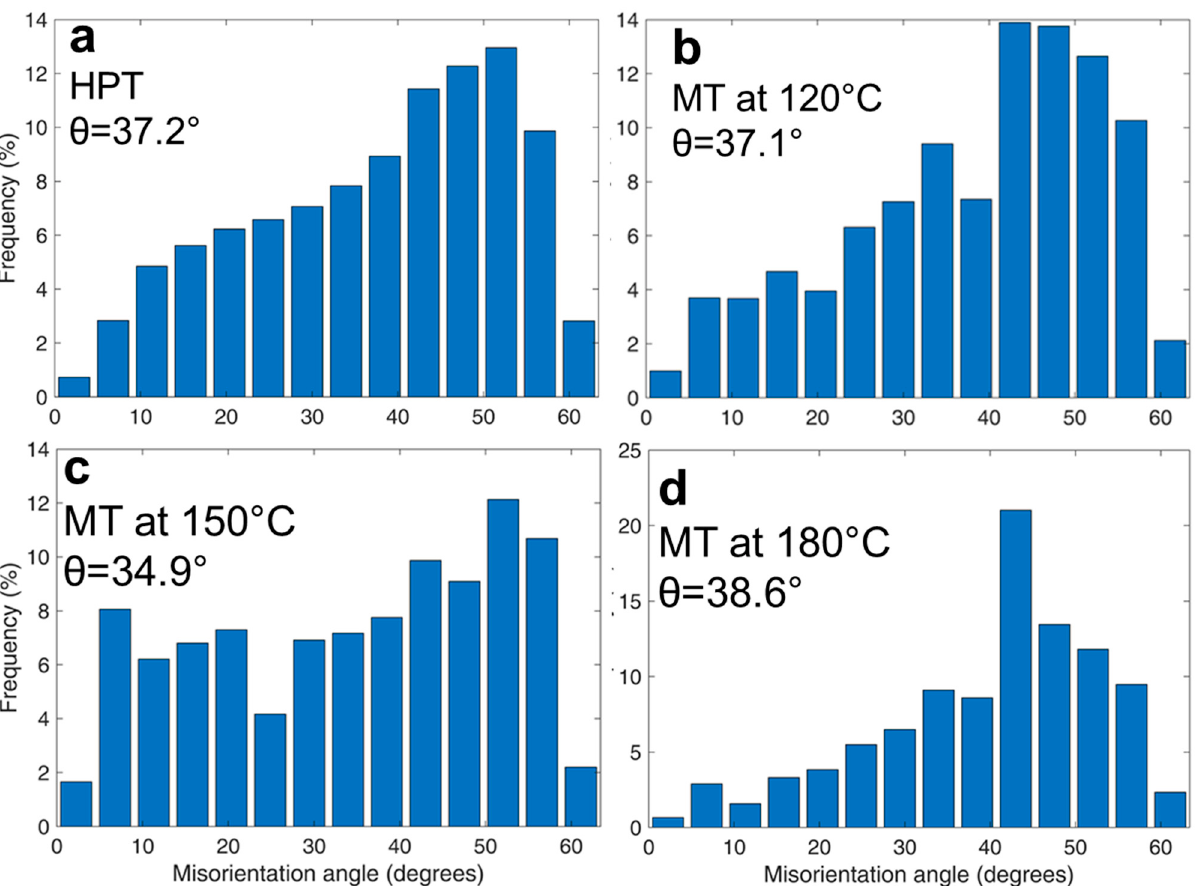
Figure 5. Distribution diagram of boundary misorientation angles depending on their volume fraction of UFG 6060 alloy after ( a ) HPT; mechanical testing at ( b ) 120 °C; ( c ) 150 °C ( d ) and 180 °C. fraction of UFG 6060 alloy after ( a ) HPT; mechanical testing at ( b ) 120 ◦ C; ( c ) 150 ◦ C ( d ) and 180 ◦